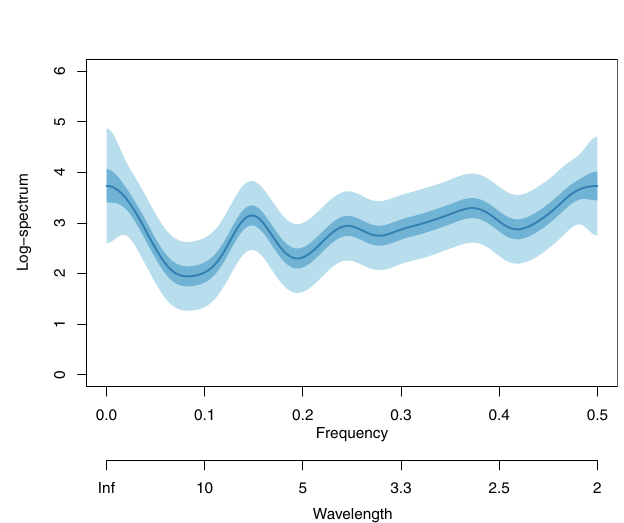
Figure 2. Bayesian log-spectral estimate of transformed UK new daily COVID-19 cases with 50% (dark blue shaded region) and 90% (light blue shaded region) credible intervals.